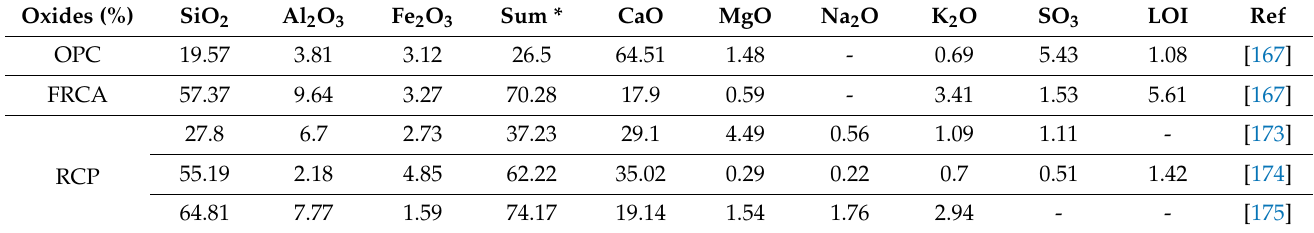
Table 16. Comparison of chemical compositions of RCP and FRCA with OPC (Note: Sum * is the sum of pozzolanic